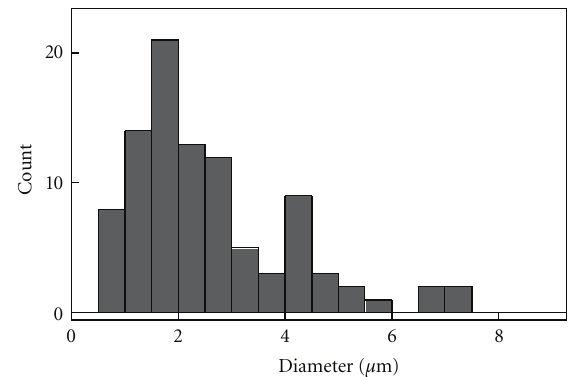
Figure 3: Histogram of diameters of as-precipitated Fe-doped C 60 nanowhiskers.